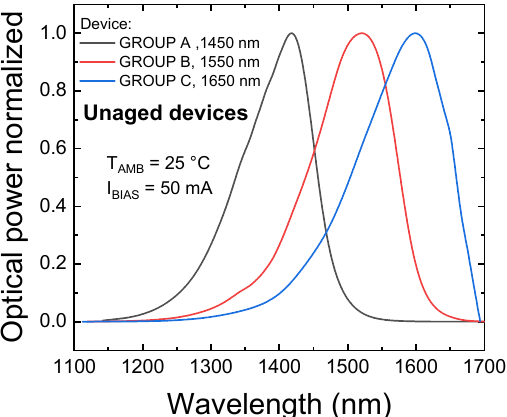
Figure 3. Normalized electroluminescence (EL) spectra, measured at T AMB = 25 ◦ C and I BIAS = 50 mA, of one representative sample for each LED group under investigation.